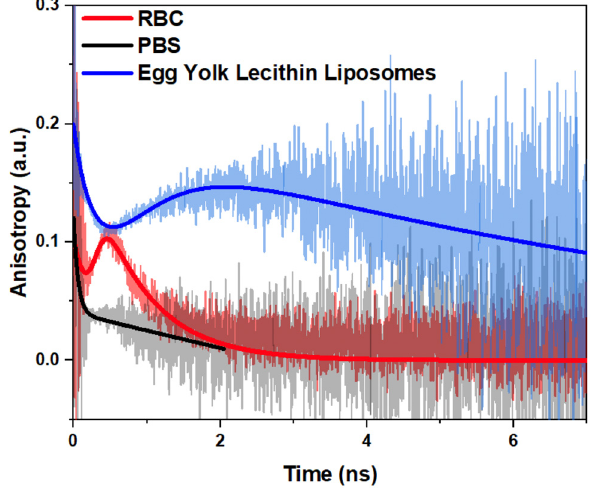
Figure 5. Analysis of anisotropy kinetics of lipophilic fluorescence dye PKH26 in the membranes of RBC, egg yolk lecithin liposomes, and phosphate-buffered saline (PBS) using the associated decay approach. Measurements were performed at 36 ° C. Concentration of PKH26 = 20 nM; hematocrit 0.1%; liposomes sample represented 1%-suspension.